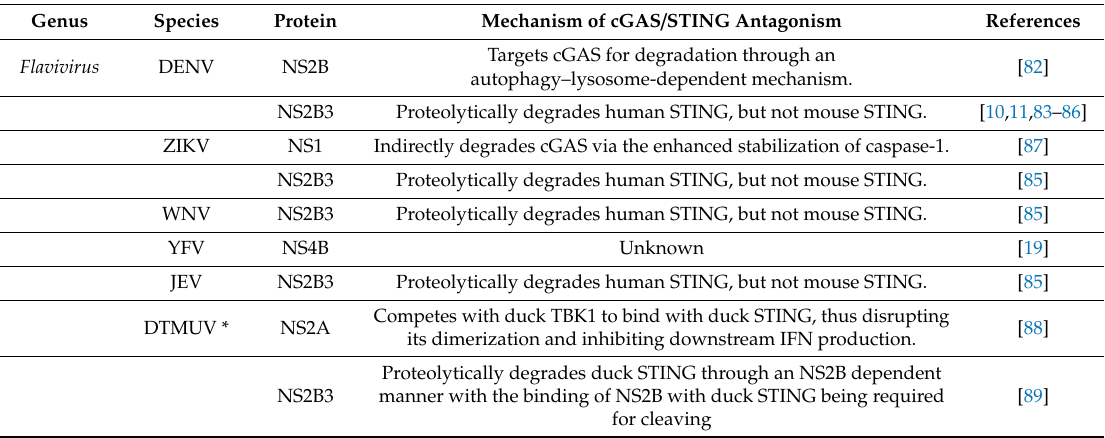
Table 1. Mechanisms of known cyclic GAMP synthase (cGAS) / stimulator of interferon genes (STING) antagonism by flaviviruses. NS, nonstructural; DENV, dengue virus; ZIKV, Zika virus; WNV, West Nile virus; YFV, yellow fever virus; JEV, Japanese encephalitis virus; IFN, interferon; TBK1, TANK-binding kinase